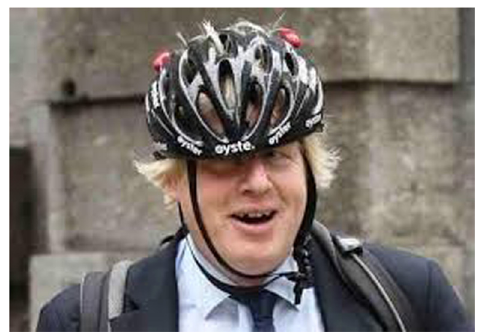
Figure 3: Man of the